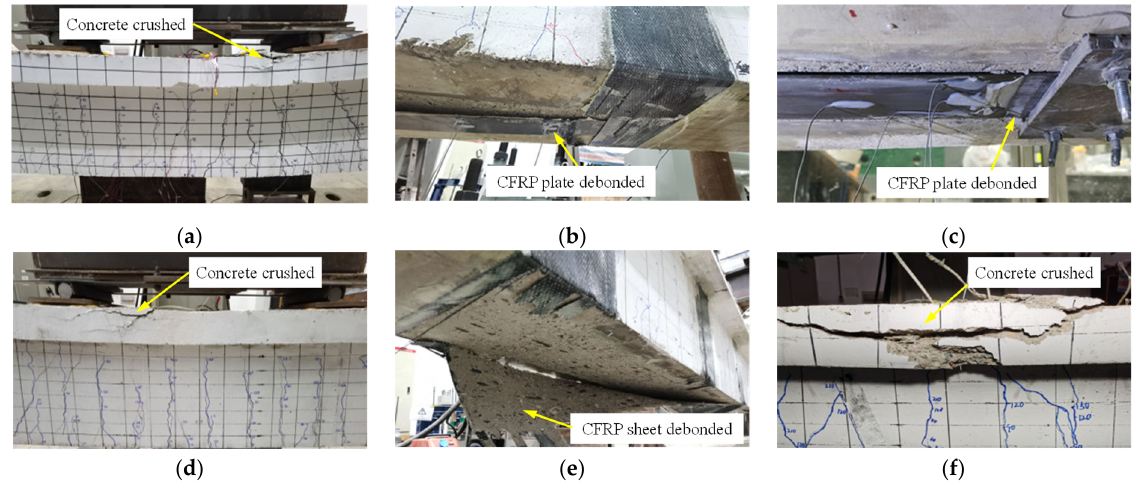
Figure 6. Typical failure photos: ( a ) BU, ( b ) BS-1, ( c ) BS-2, ( d ) BS-3, ( e ) BS-4, and ( f ) BP-2.